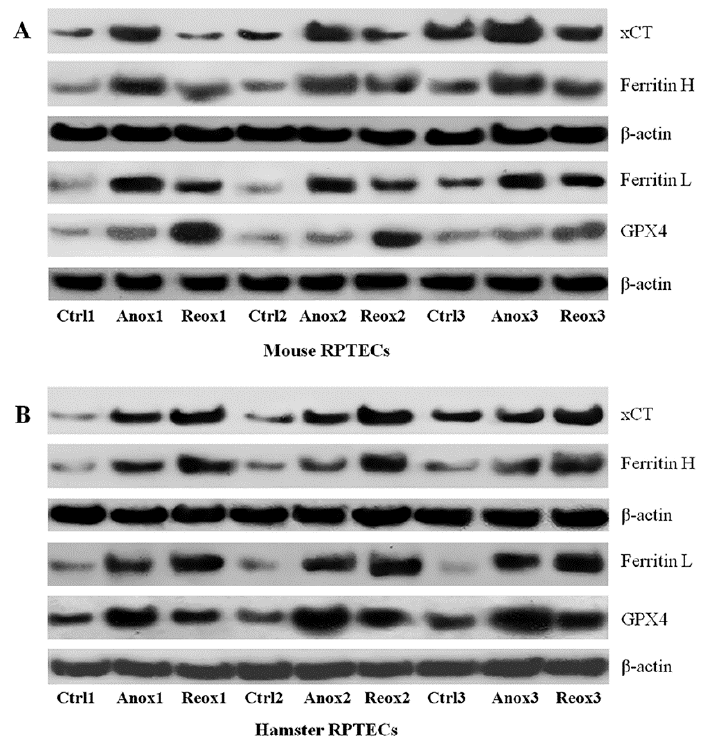
Figure 3. Western blots from mouse and hamster RPTECs subjected to anoxia or reoxygenation. RPTECs were subjected to 24 h of anoxia or 24 h of anoxia followed by reoxygenation for 2 h. These experiments were performed nine times. Panel ( A ) represents the Western blots for xCT, ferritin H, ferritin L, and GPX4 from three representative experiments in mouse RPTECs. Panel ( B ) represents the same blots in hamster RPTECs. Ctrl stands for control, Anox for anoxia, and Reox for reoxygenation.